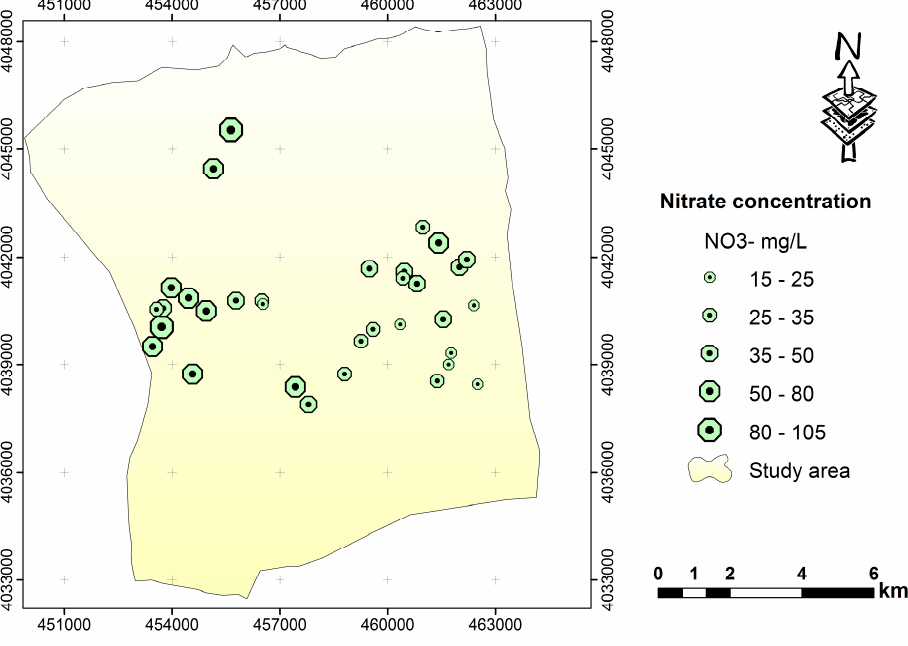
Figure 10. The spatial distribution of the boreholes and their nitrate concentration. Table 10. Summary statistics of nitrate